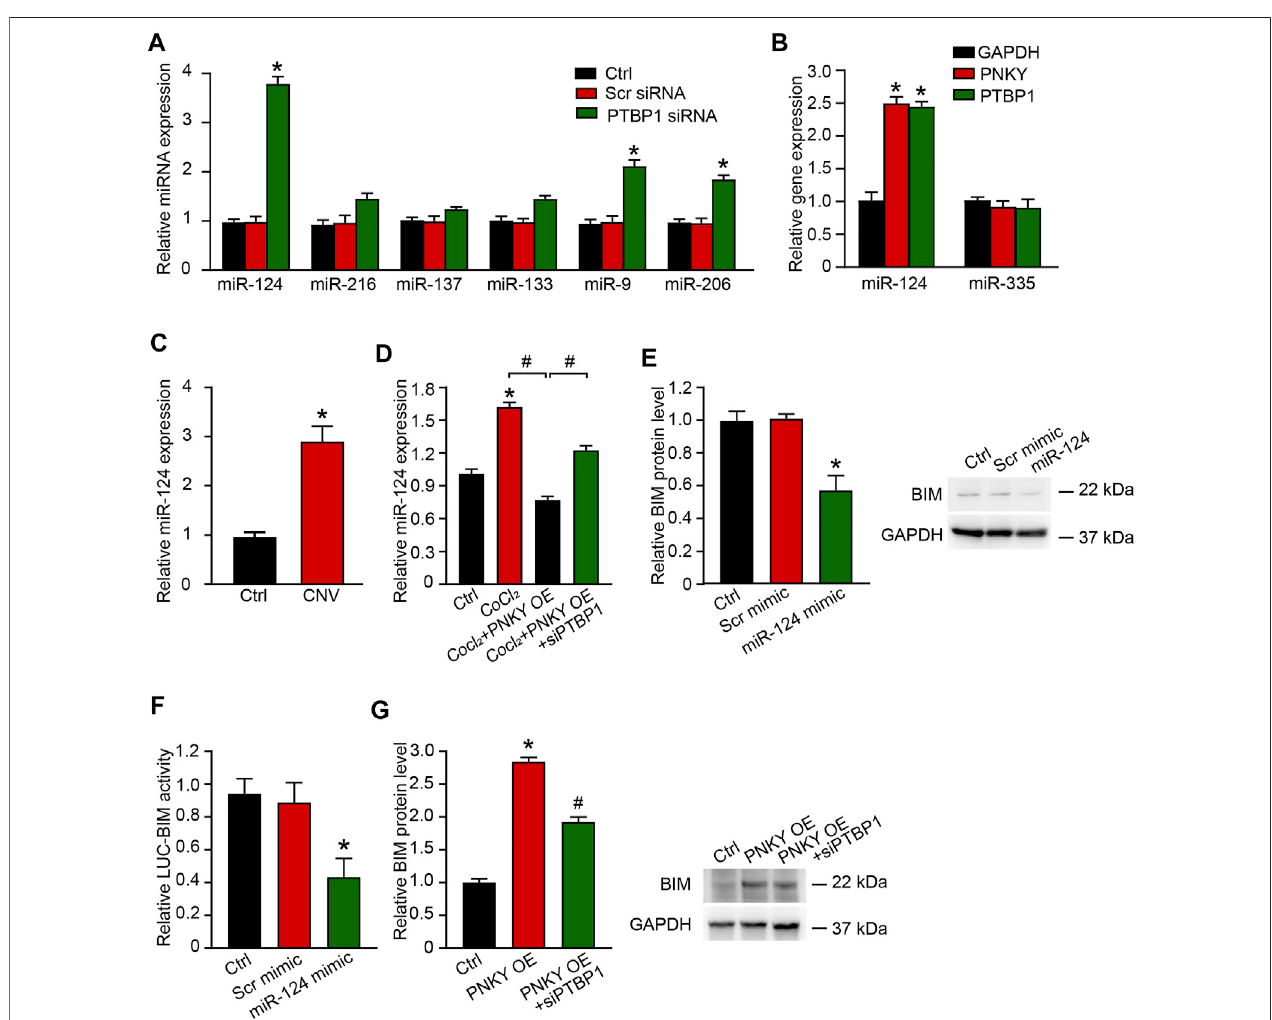
FIGURE 6 | PNKY – PTBP1 interaction functions by blocking miRNA-124 biogenesis in CNV development. (A) RF/6A cells were transfected with scrambled (Scr) siRNA, PTBP1 siRNA, or left untreated (Ctrl) for 24 h. qRT-PCRs were performed to detect miRNAs expression ( n = 4, * p < 0.05 versus Scr siRNA, one-way ANOVA followed by Bonferroni ’ s post hoc test). (B) RF/6A cells were transfected with the 3 ′ -end biotinylated miRNA duplexes for streptavidin capture. qRT-PCRs were performed to detect the levels of PNKY, PTBP1, and GAPDH in the input and bound fractions and the relative immunoprecipitate (IP)/input ratios were plotted. (C) qRT-PCRs were conducted to detect the expression of miR-124 in CNV lensions ofC57BL/6J mice ( n = 6 animals per group, * p < 0.05, Mann – Whitney U test). (D) RF/ 6Acellswereexposedto200 μ